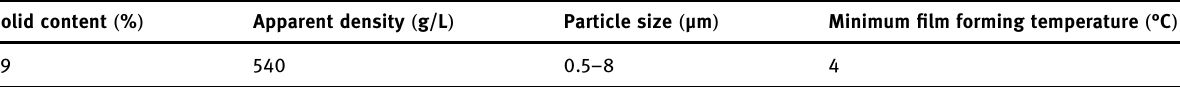
Table 3: Technical indicators of polymer powder made up of ethylene vinyl acetate copolymer Solid content ( % )